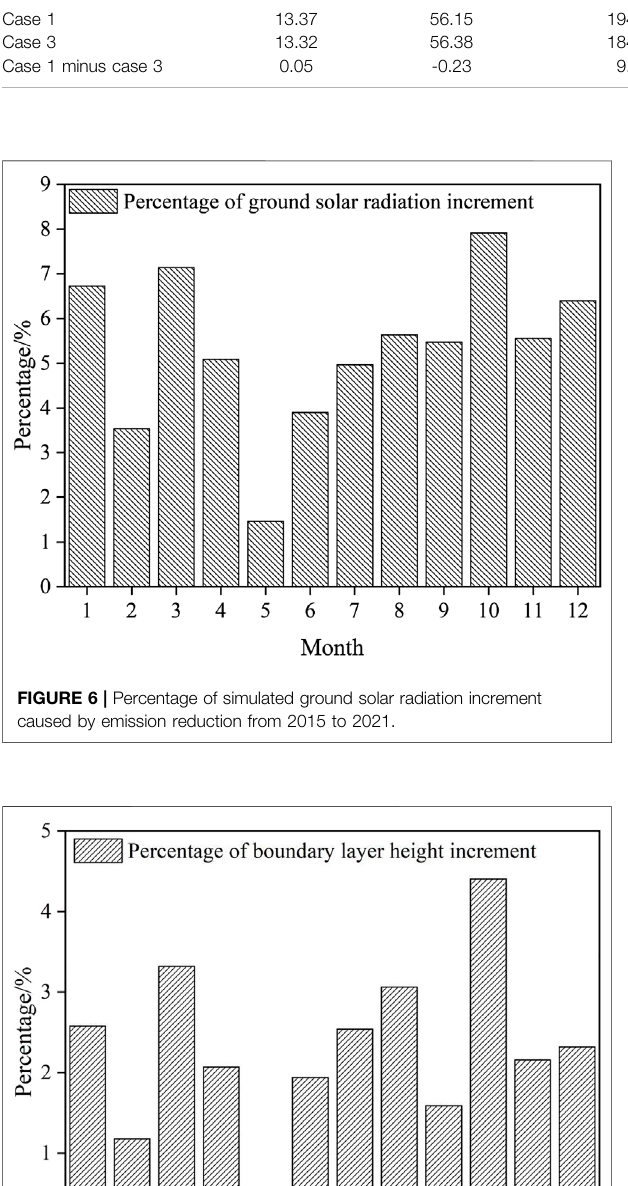
Frontiers in Environmental Science |